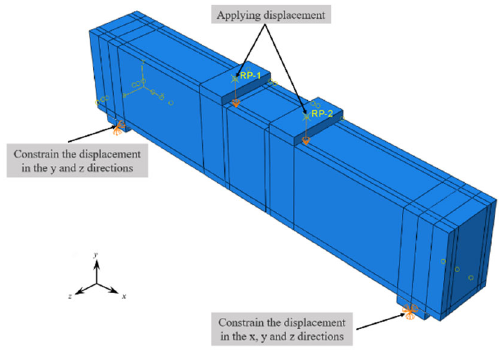
Figure 8. Finite element model boundary conditions.